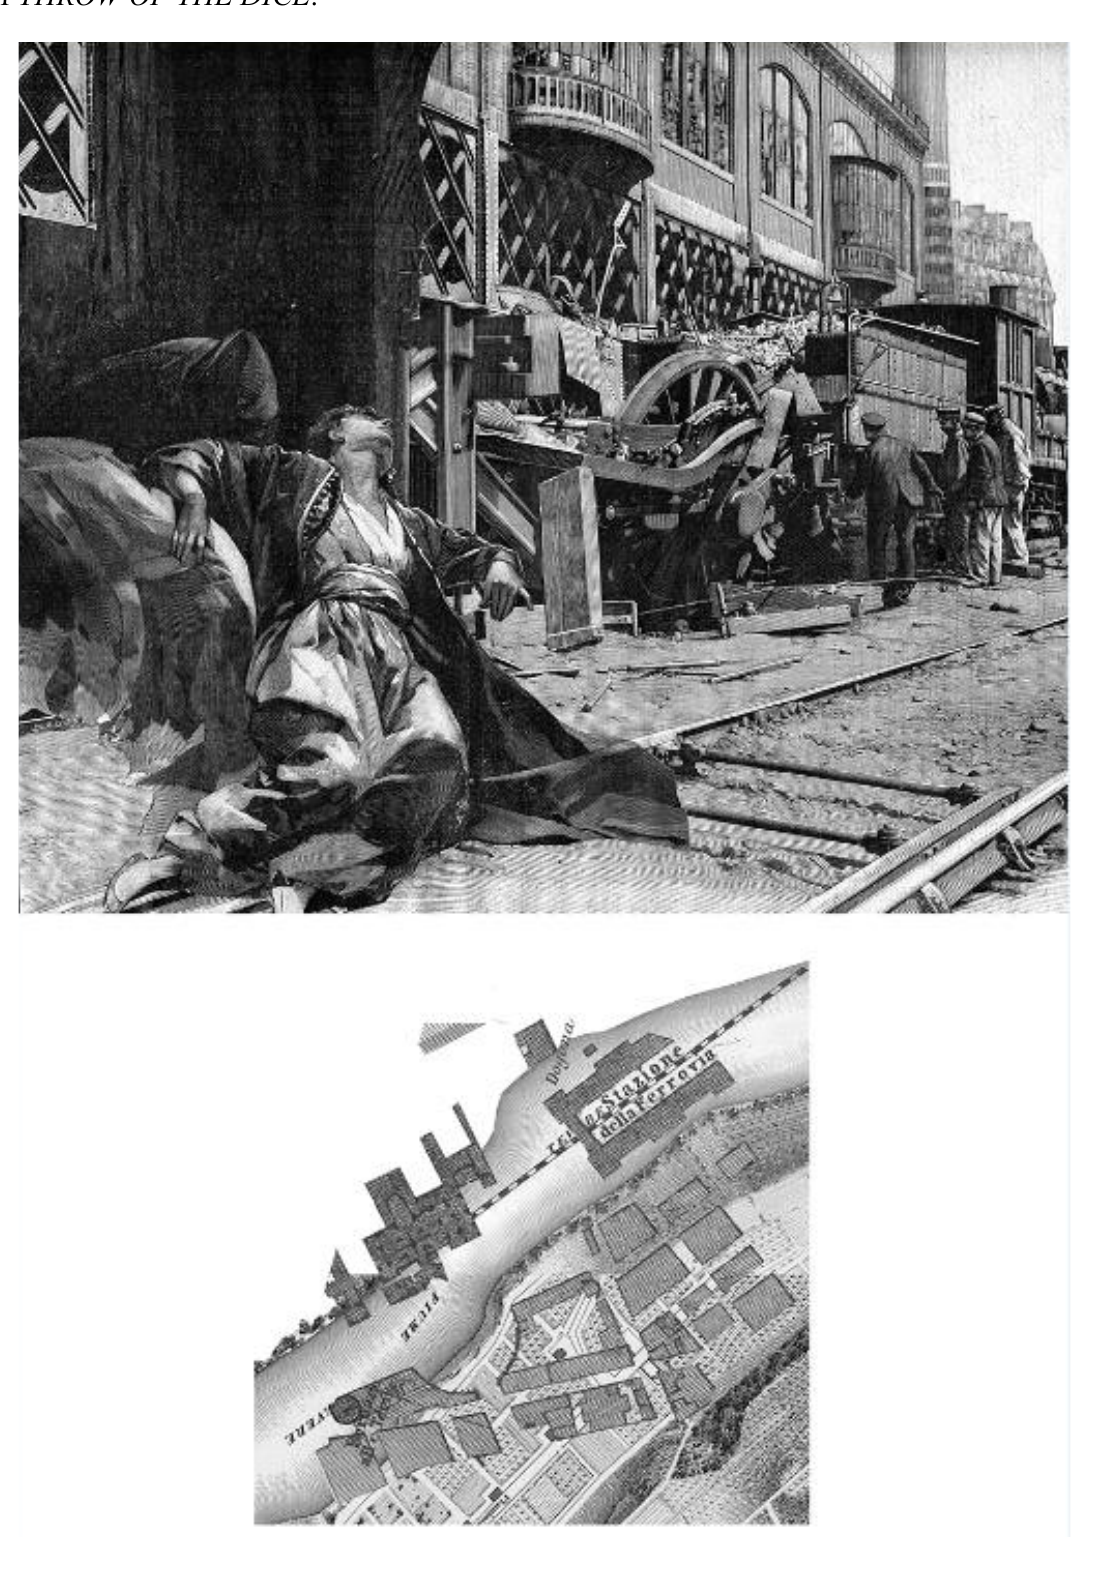
Figure 7. Paper Collage comprised of original engravings from La Grande Illustré (1904): A THROW OF THE DICE